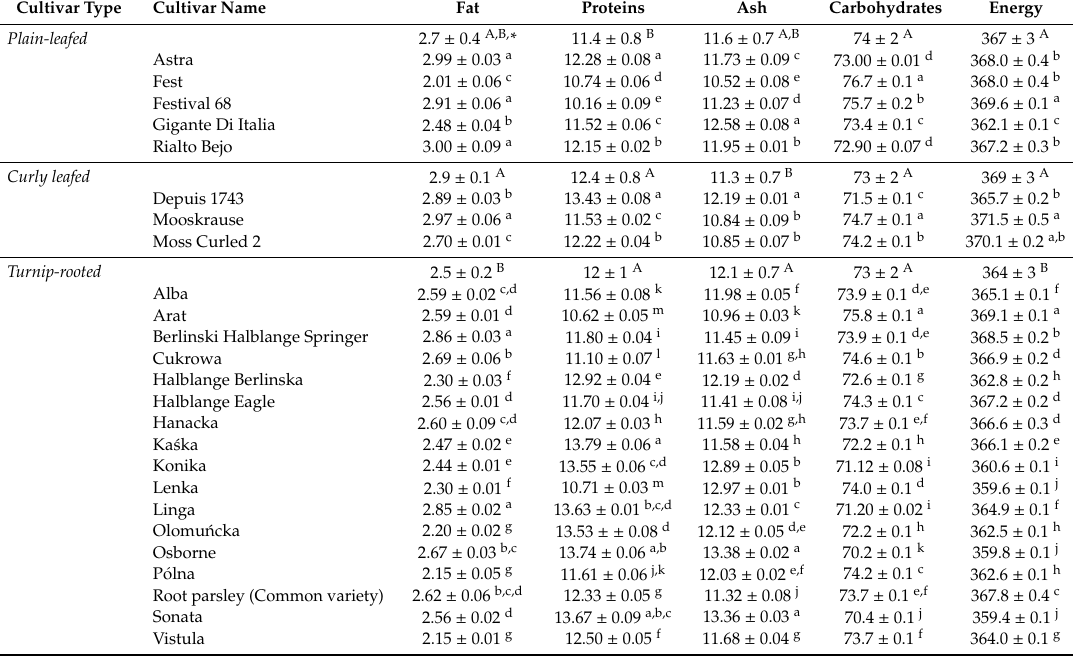
Table 2. Nutritional value (g / 100 g dw) and energy (kcal / 100 g dw) of the studied parsley leaf samples (mean ±